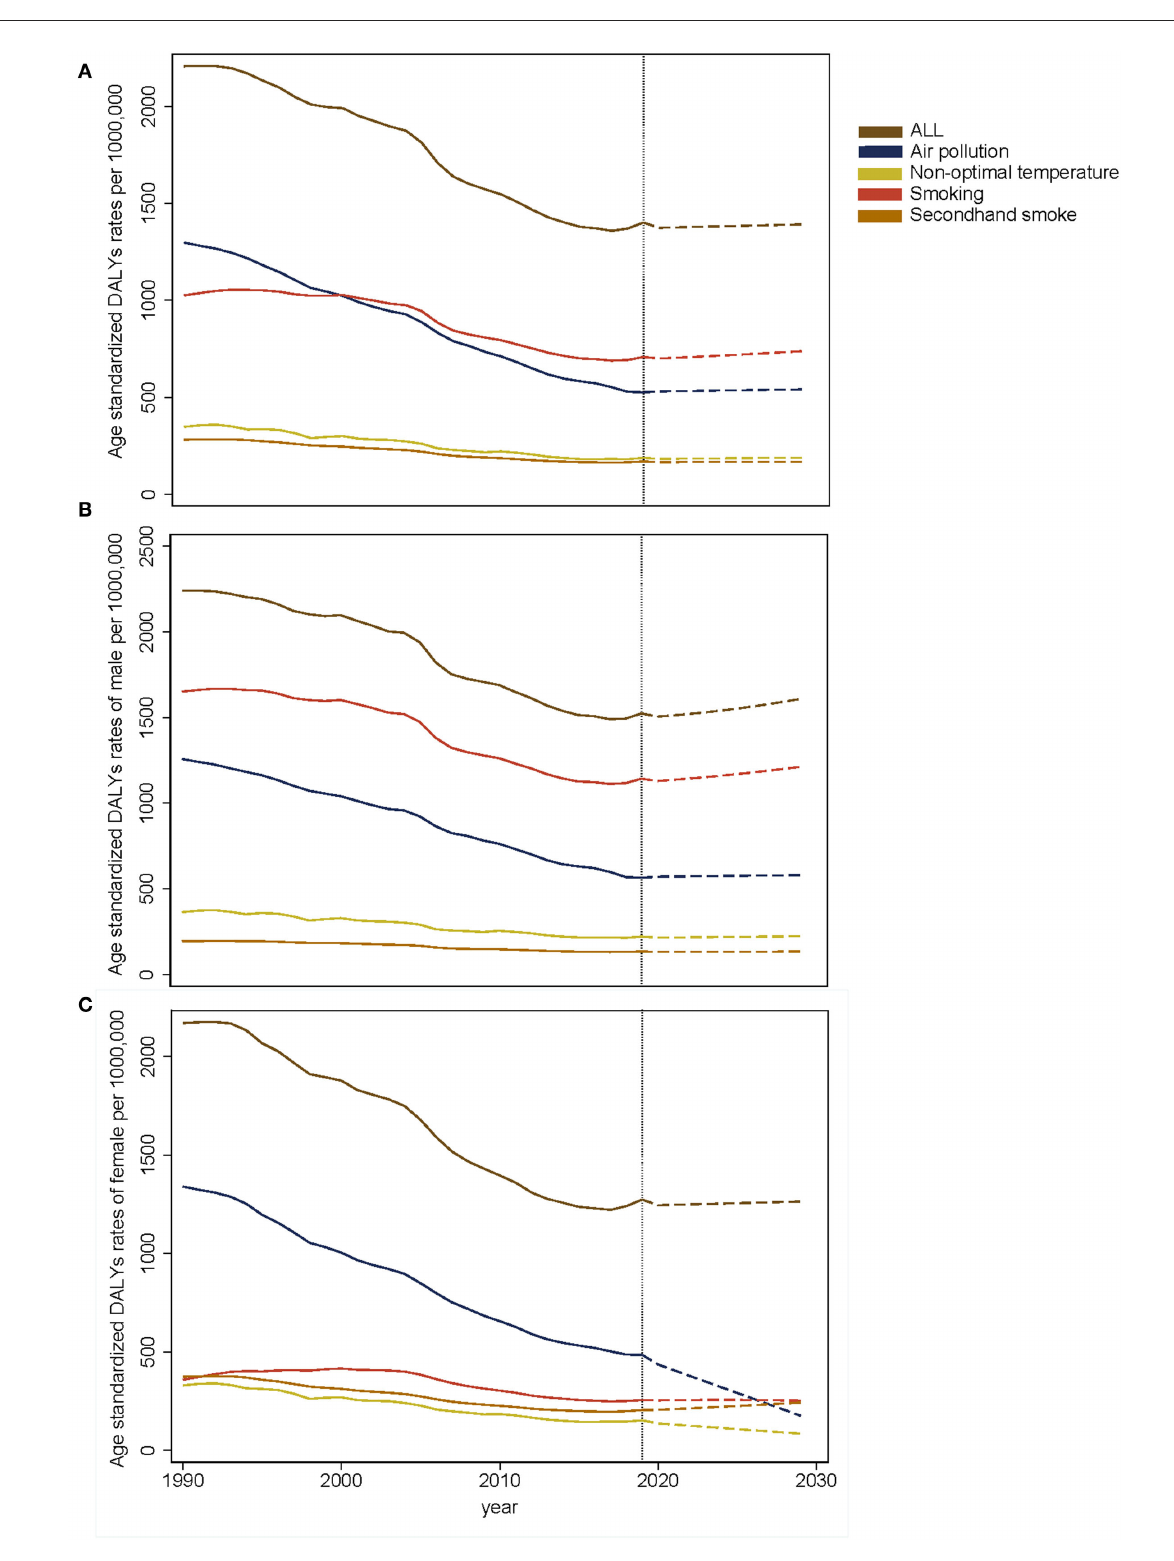
FIGURE8 The prediction of ASR of COPD DALY in all (A) , male (B) , and female (C)